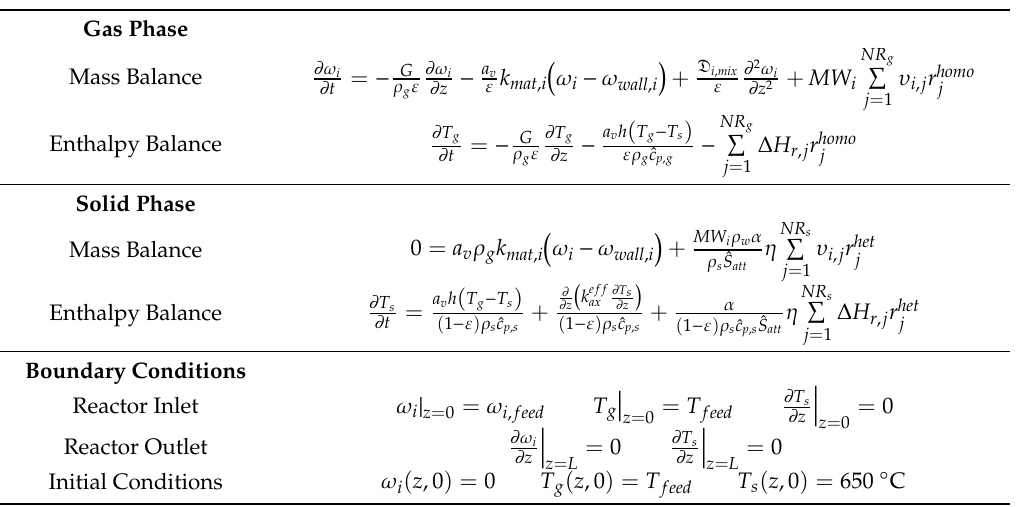
Table 4. Model equations.